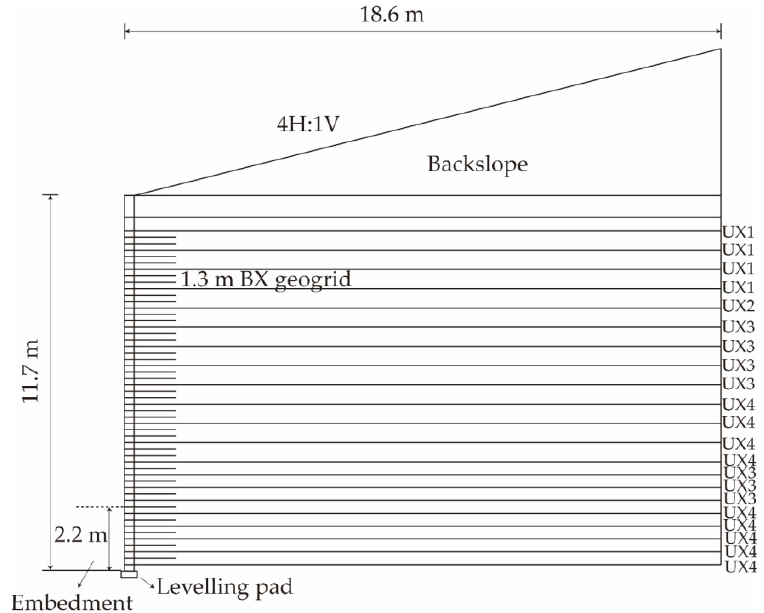
Figure 1. The cross-section of the field geosynthetic-reinforced soil (GRS) wall with secondary reinforcement.